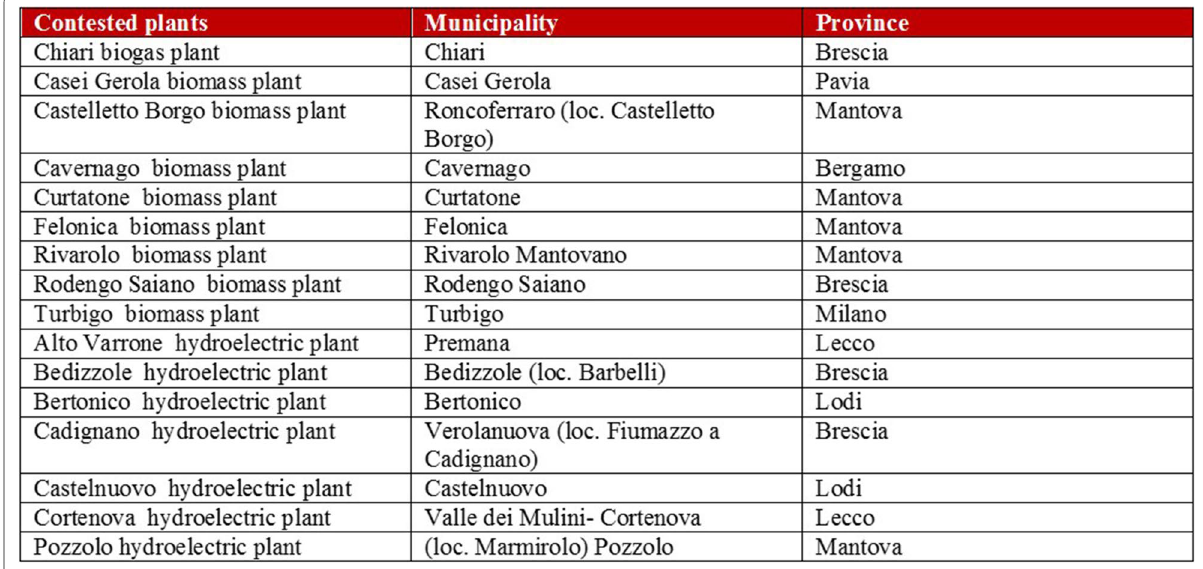
Fig. 4 The example of the NIMBY Forum and RES contested plants in Lombardia—excerpt from the table: contested national systems, drafted by the NIMBY Forum Observatory 2014/2015